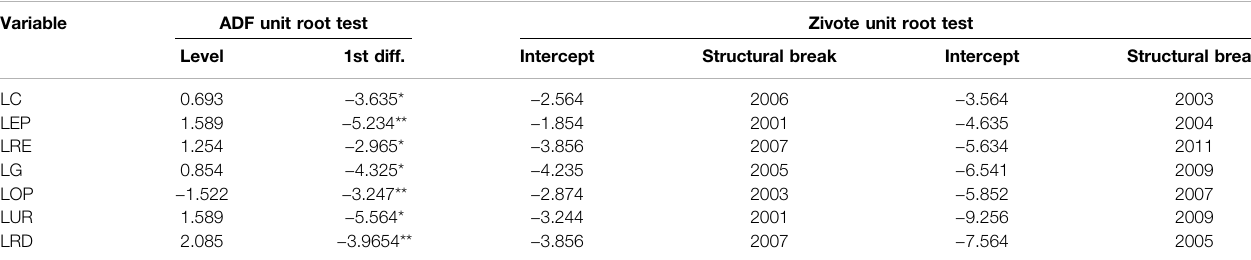
TABLE 4 | Outcomes of ADF and Zivote unit root test. Variable